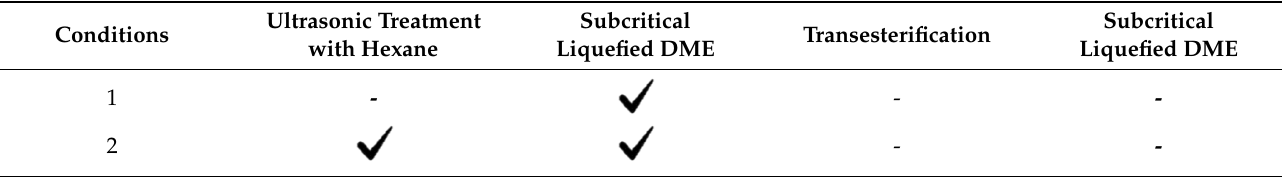
Table 1. Conditions for policosanol extraction of filter mud.